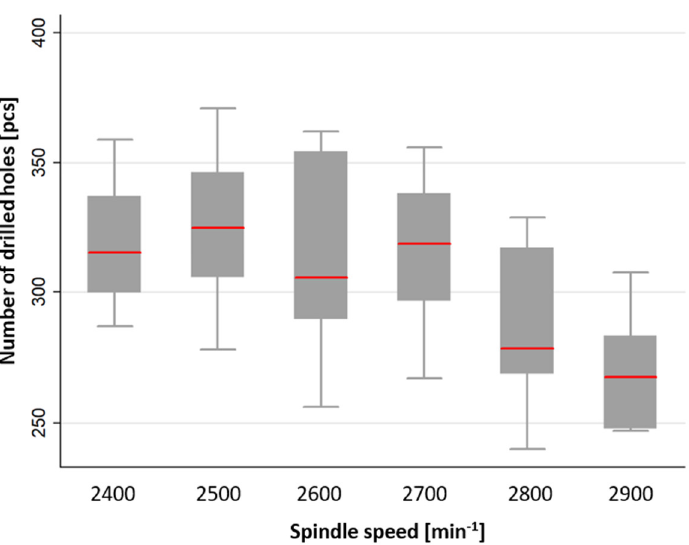
Figure 10. Plotted comparison of the number of drilled holes up to the moment of tool damage and the speed used in the experiment. Table 2. Results of a comparison of the number of holes drilled up to the moment of tool damage in terms of speed change.